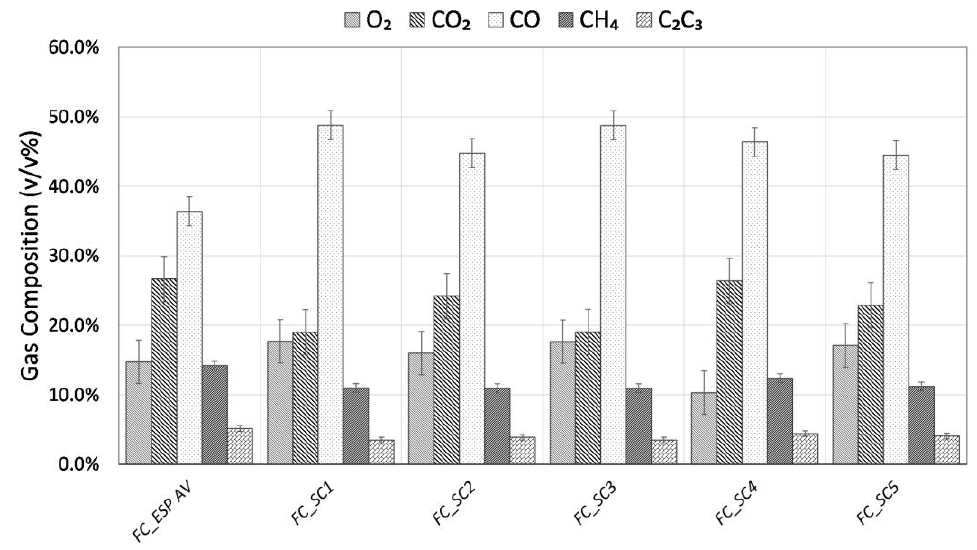
Figure 3. Produced gas composition.